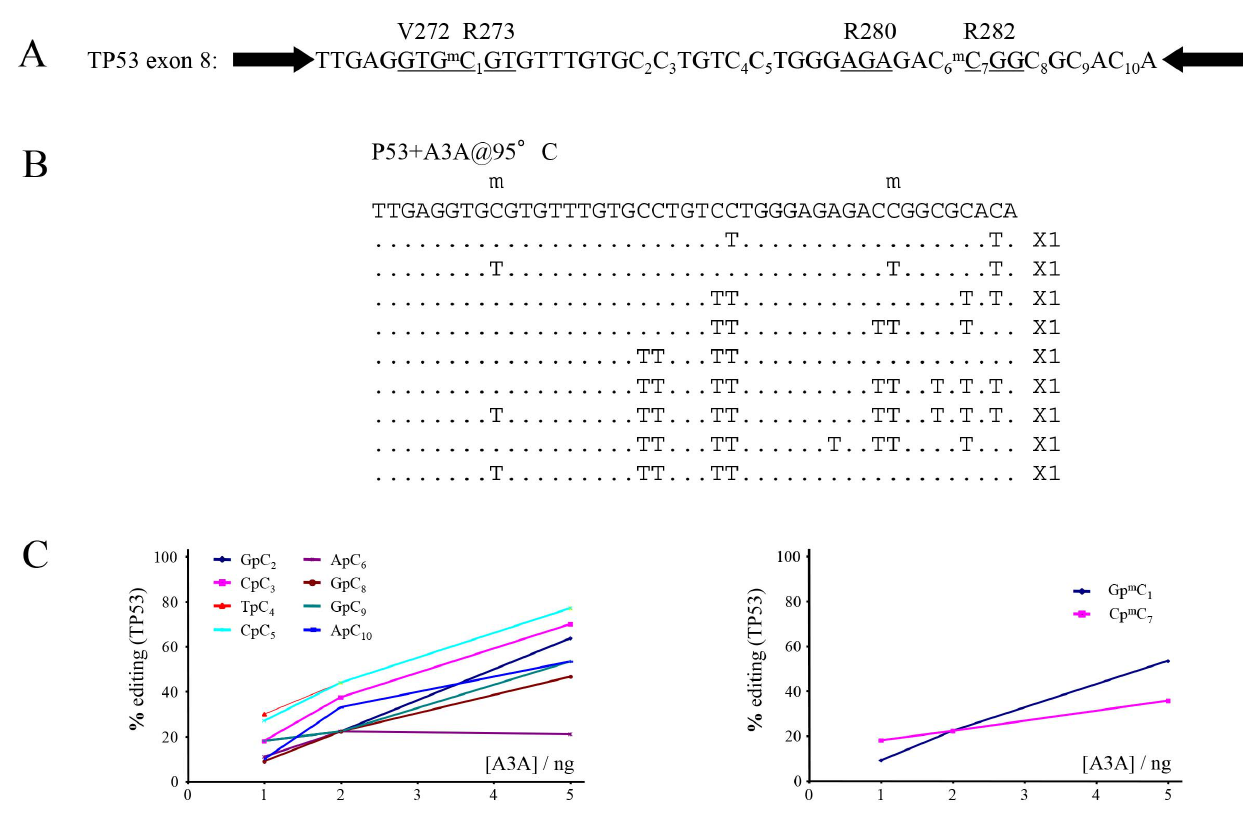
Figure 3. A3A deamination of an oligonuclotide harbouring two methylated CpGs that are TP53 mutation hotspots in cancers. A) The TP53 target sequence is nested between two PCR primer targets (black arrows). The underlined triplets highlight the codons which are frequently substituted in cancers. B) A selection of deaminated TP53 sequences with the number of mutant sequences shown to the right. C) Site specific cytidine and 5-methyl cytidine deamination frequencies as a function of A3A concentration.